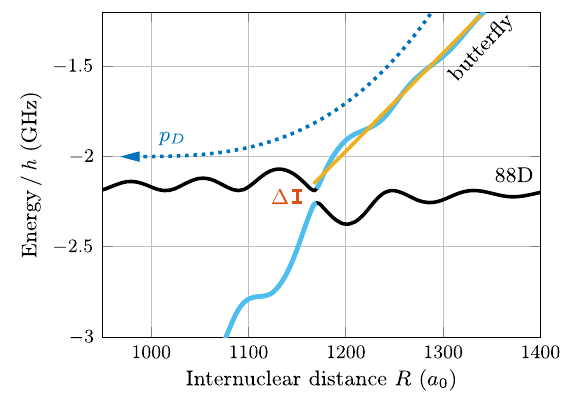
FIG. 12. Avoided crossing between the butterfly state (blue) and the 88 D state (black). This avoided crossing is studied by means of a Landau-Zener approach with Eq. (C1), where Δ denotes the energy gap at the crossing point and the orange line depicts the slope at the crossing